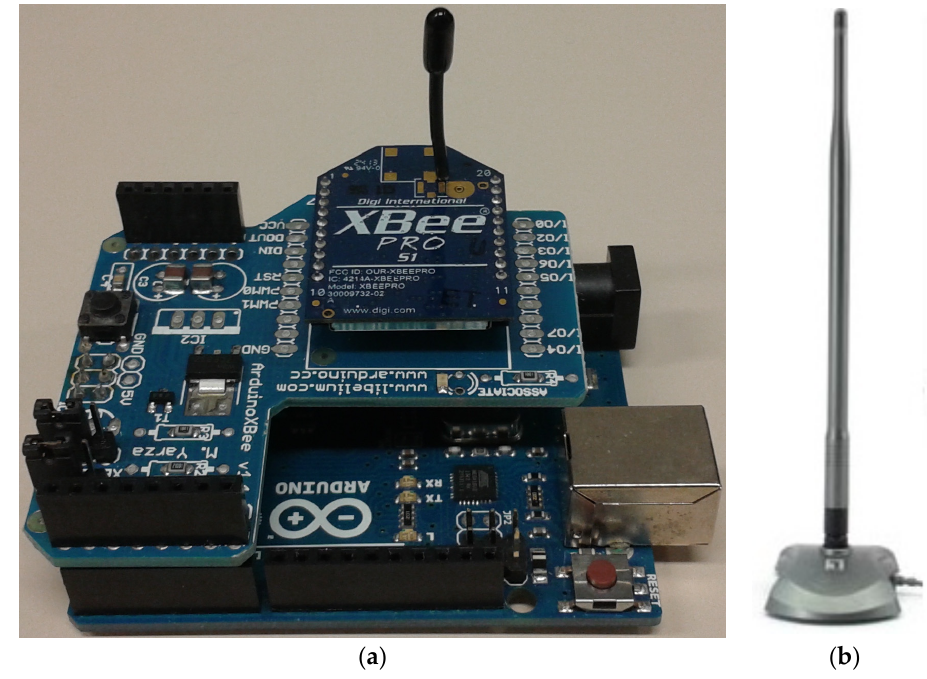
Figure 4. ( a ) XBee-Pro module used as transmitter; ( b ) 2.4–2.5 GHz band monopole antenna used